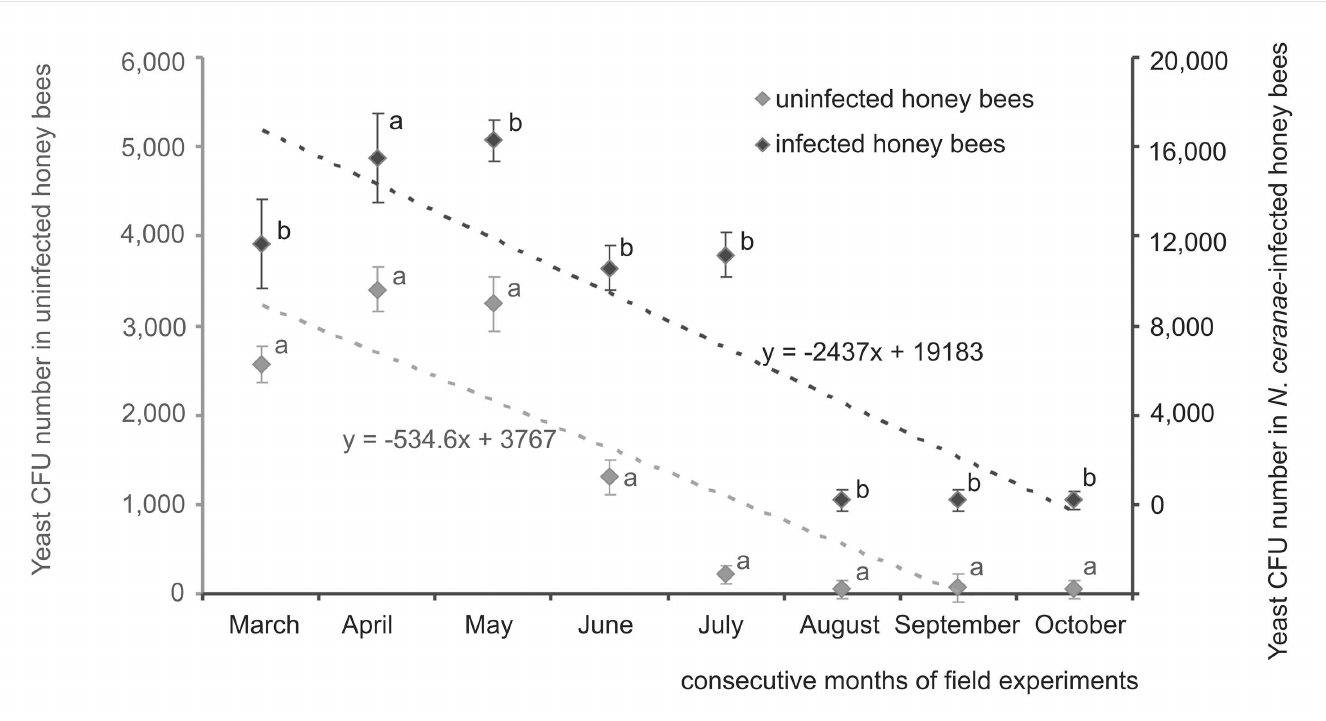
Fig 2. Field tests. Changes in the intestinal yeast CFU number per honey bee worker observed from March to October in uninfected and N . ceranae -infected honey bee colonies. Data obtained from measurements conductedon a monthly basis for the first five days of each month from March to October in 2014 and 2015. Different lower case letters indicate significant differences (p < 0.05) between uninfected and N . ceranae -infected colonies (one-way ANOVA was performed separately for each month). Dotted lines represent regressionlines. Diamondshapes ( ♦ ) represent means while error bars indicate standard